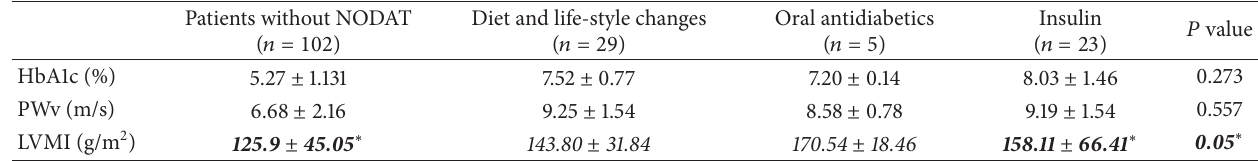
Table 3: HbA1c, PWv, and LVMI values of patients according to NODAT treatment modalities. Patients without